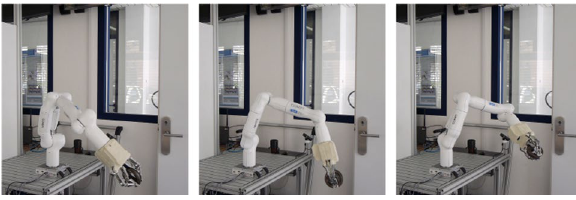
Fig. 19 Degradation of the tracking performance due to an unmodeled payload with a mass of